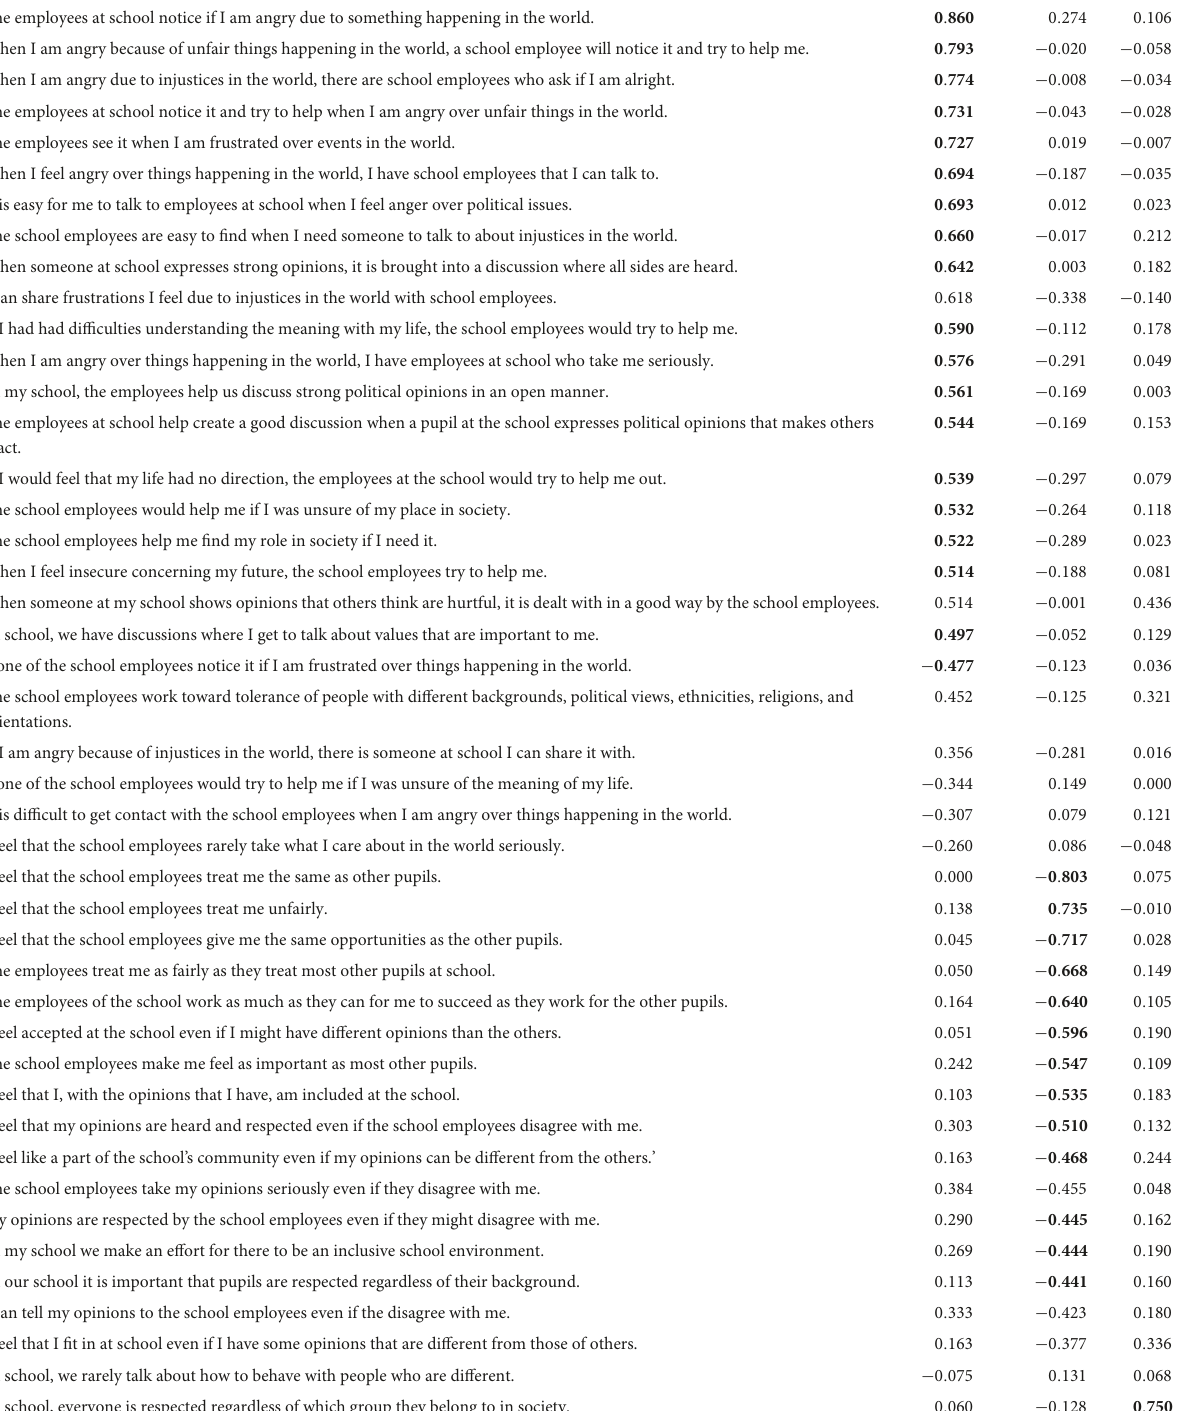
Factor Attentiveness Equality